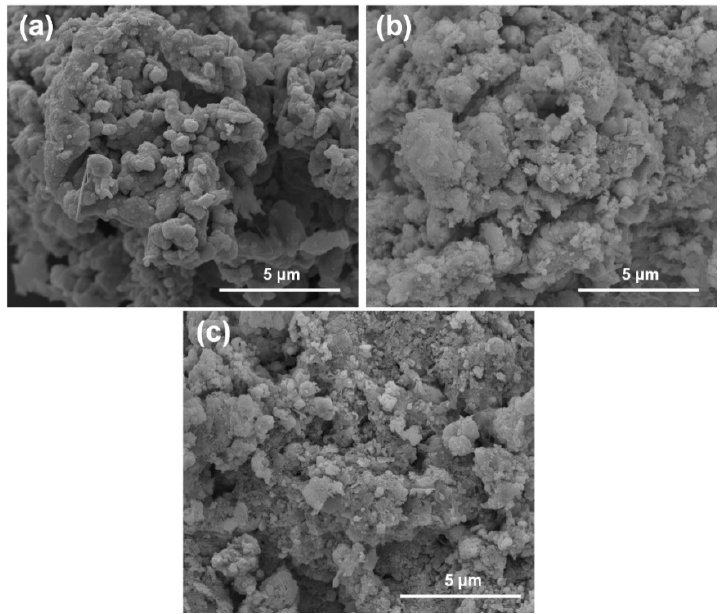
Figure 5. FESEM micrographs of ( a ) Ac-ZVI; ( b ) Ac-ZVI after PMS oxidation; ( c ) Ac-ZVI after PDS oxidation.